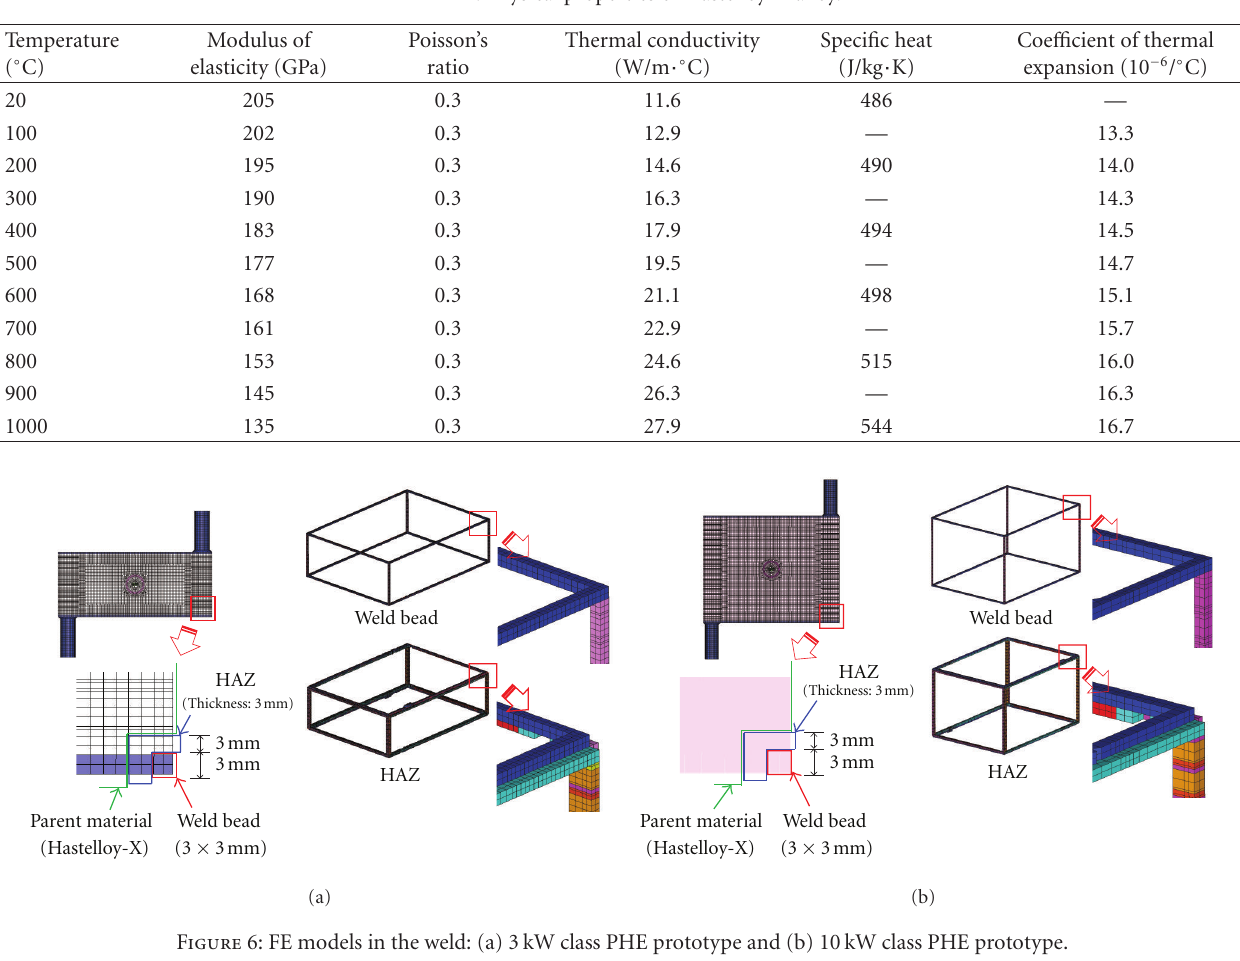
Table 2: Physical properties of Hastelloy-X alloy.